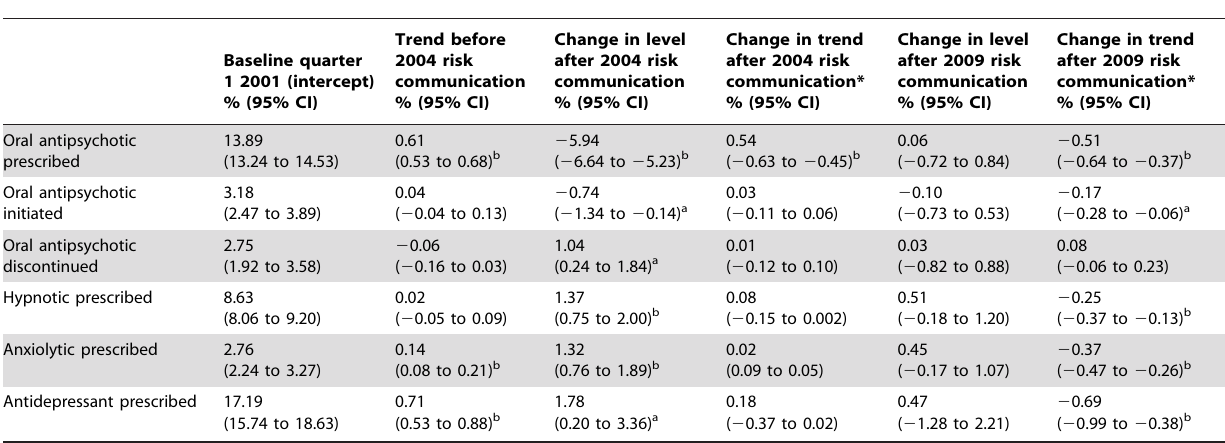
Table 2. Segmented regression analysis of changes in antipsychotic and other psychotropic prescription in relation to the 2004 and 2009 risk